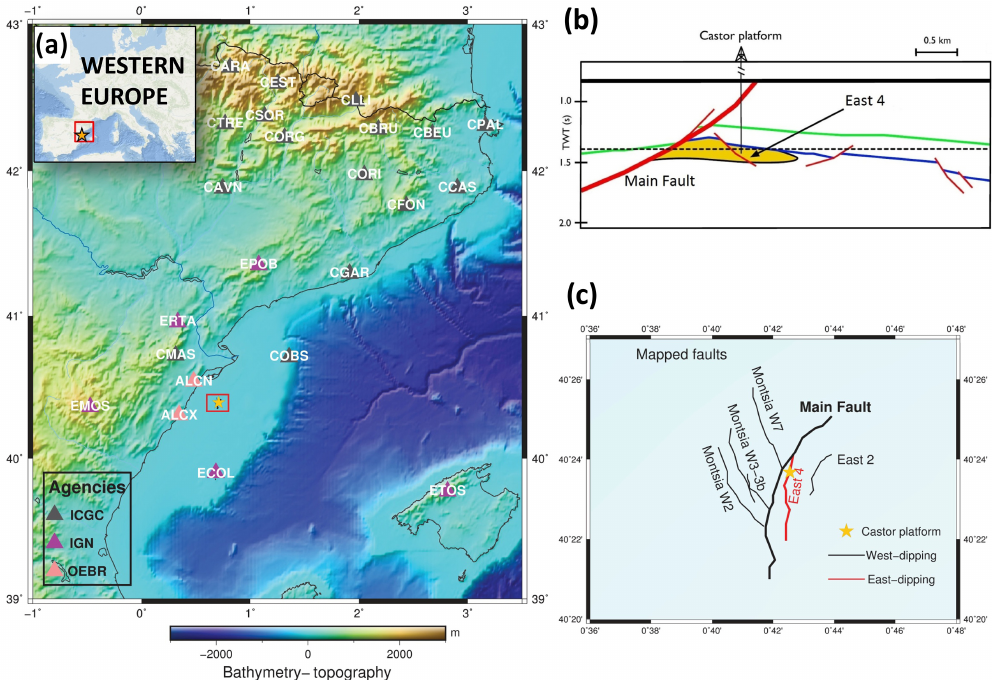
Figure 1. Location of the study; the Castor platform is represented with an orange star. (a) General view showing existing permanent seismic stations around the UGS and main stations in the Catalonia area. The ECOL station was set up after the beginning of seismicity and was not used in the majority of the available earthquake locations. See legend for agencies. (b) Sketch of the UGS structure after the Shell seismic profile in Seeman et al. (1990); vertical scale is in two-way travel time. A rough approximation of the reservoir body is depicted in yellow, and stratigraphic markers are shown in blue and green (modified from Cesca et al., 2014). (c) Detailed view of known faults in the area modified from Cesca et al. (2014) according to the red area highlighted in panel (a) . The map view is plotted at the approximate depth indicated by the discontinuous line in panel (b) .